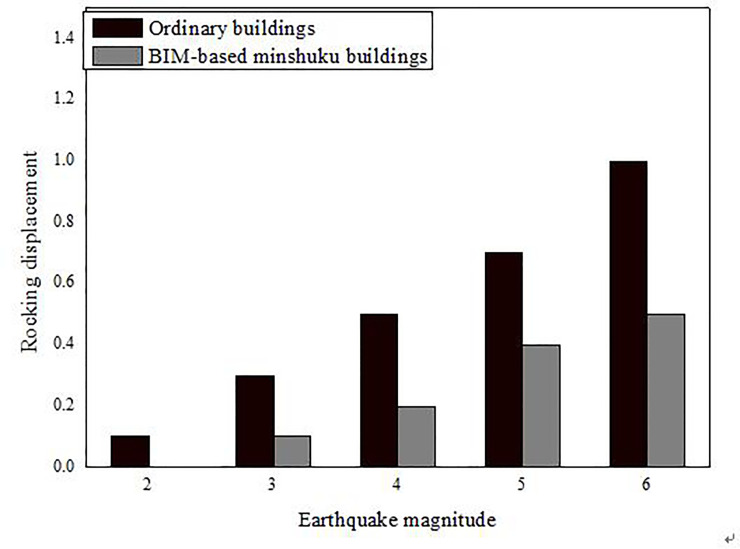
The displacement of BIM-based homestay under earthquake conditions.